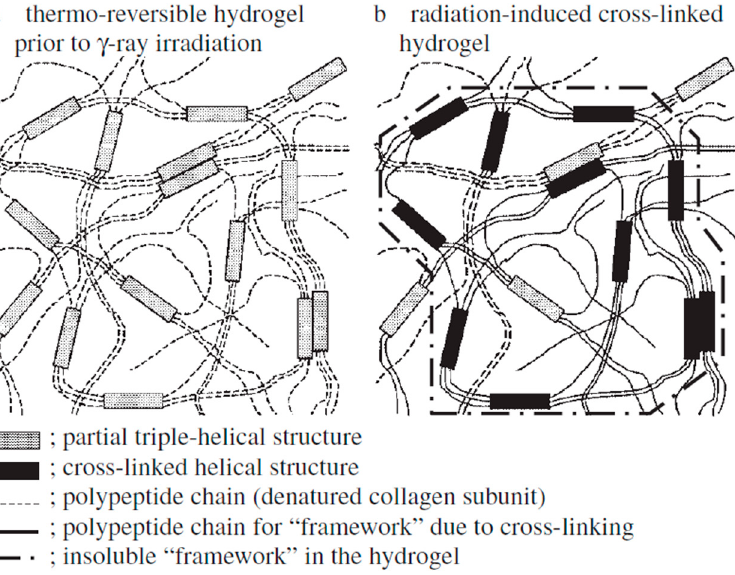
Figure 11. Schematic diagram of insoluble gelatin hydrogel formation by the radiation induced linking. ( a ) represents thermo-reversible hydrogel prior to γ -ray irradiation, while ( b ) represents cross-linking. " a " represents thermo-reversible hydrogel prior to γ -ray irradiation, while " b " repre- sents radiation-induced cross-linked hydrogel. Reproduced with permission from [176]. Chemical Society of Japan, 2007. of Japan,